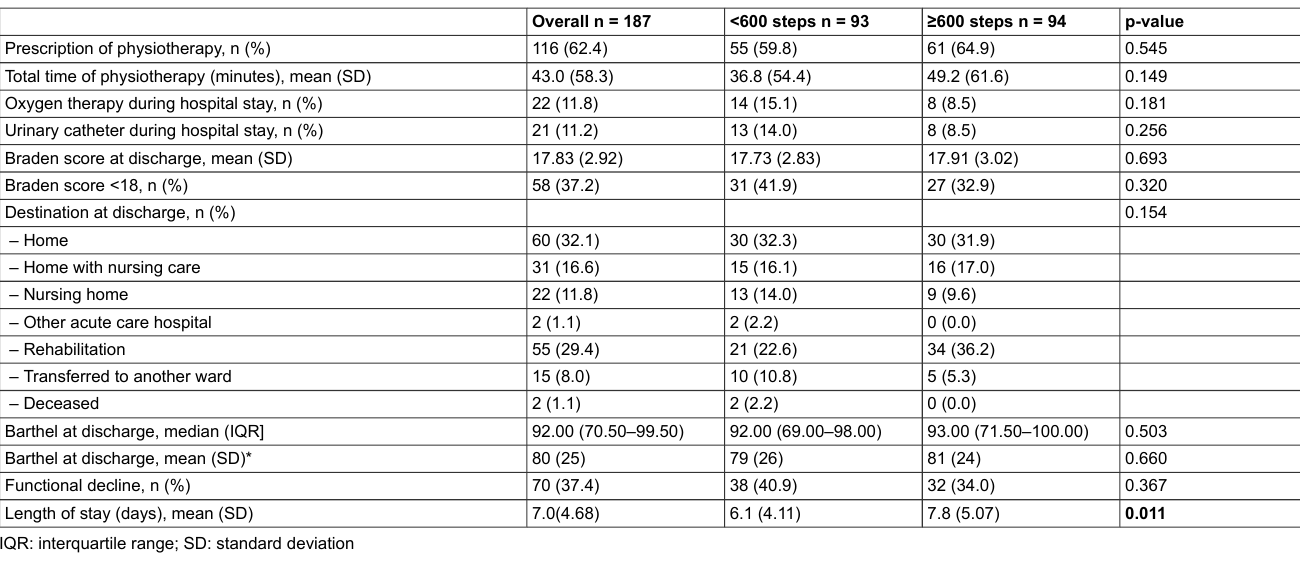
Table 2: Hospital-related factors and discharge characteristics of the study sample, stratified by the median number of